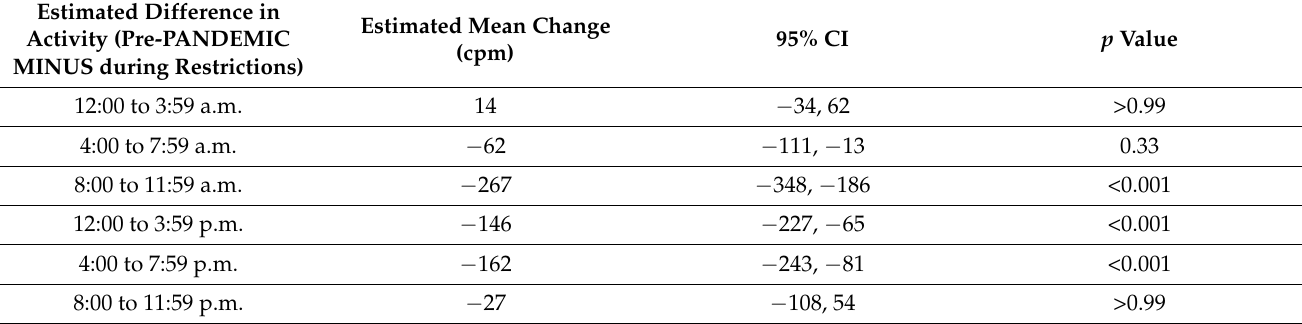
Table 2. Estimated change in activity during social restrictions compared to pre-pandemic by 4-h intervals within a 24-h period ( n = 19). Estimated Difference